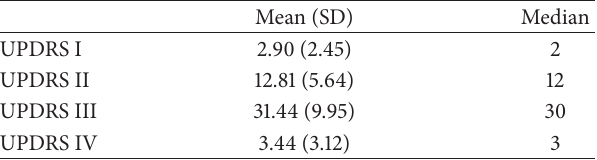
Table 6: UPDRS subscales ( 𝑛 = 105 ).